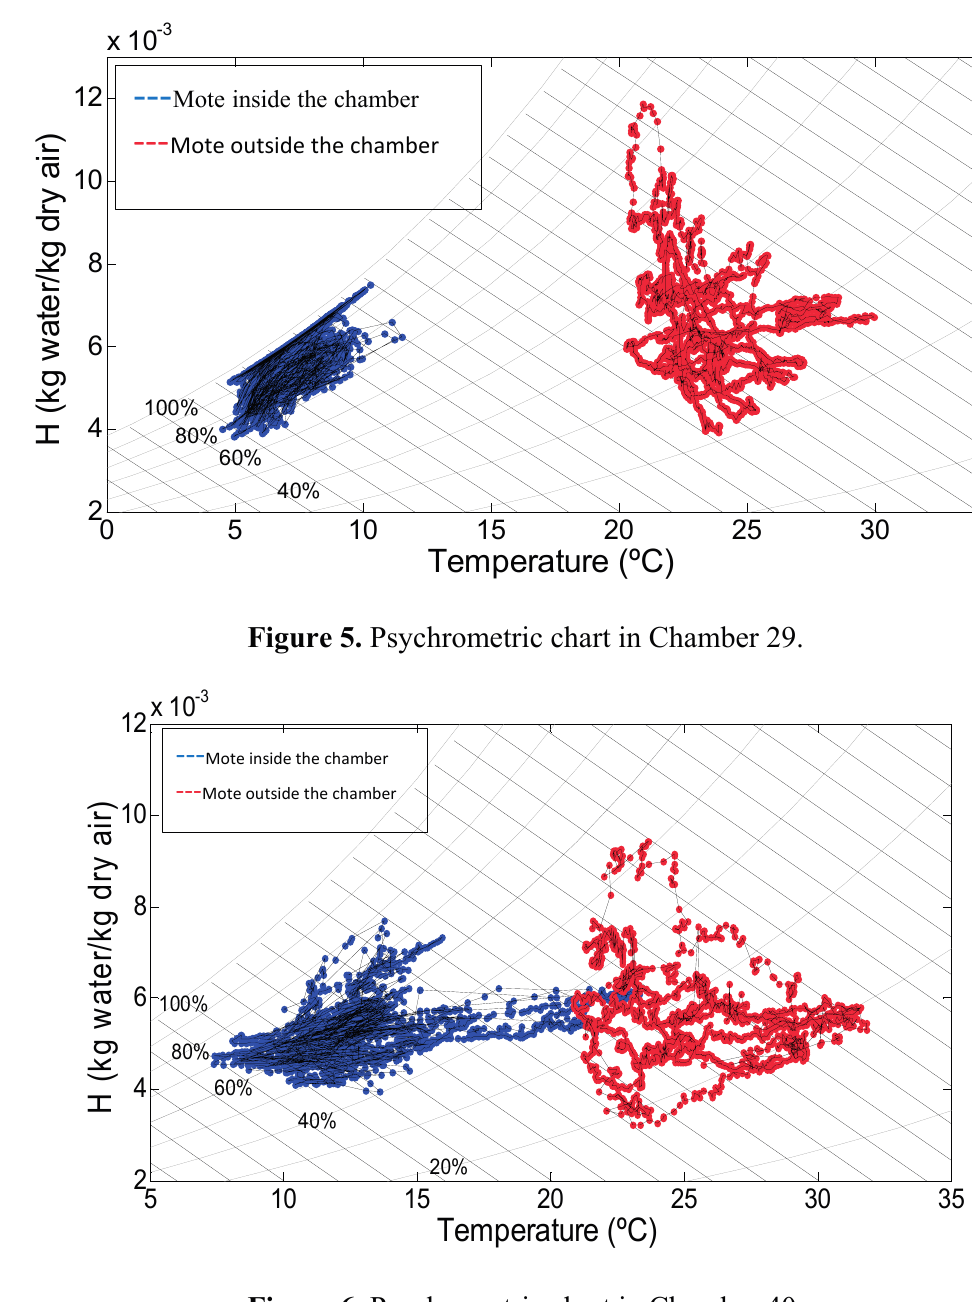
Figure 6. Psychrometric chart in Chamber